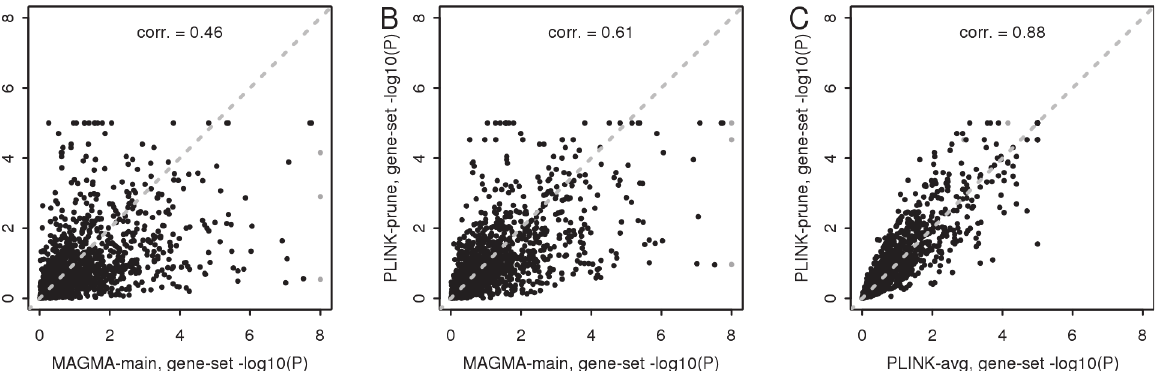
Fig 2. Comparison of self-contained gene-set analysis results. Gene set — log10 p-values from the CD data self-contained gene-set analysis for MAGMA and PLINK. Panel (A) shows the PLINK-avg (no pruning) results compared with the MAGMA-main analysis, panel (B) the PLINK-prune results compared with the MAGMA-main analysis and (C) the two PLINK analyses compared to each other. P-values below 10 – 8 are truncated to 10 – 8 (grey points) to preserve the visibility of the other points.